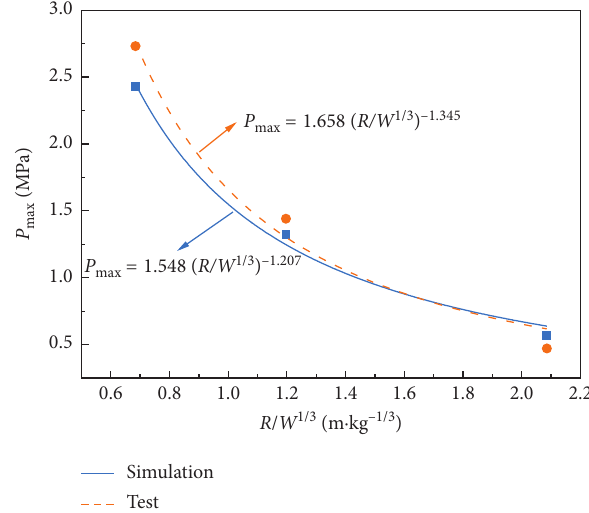
Figure 6: Relationship between peak pressure and scaled